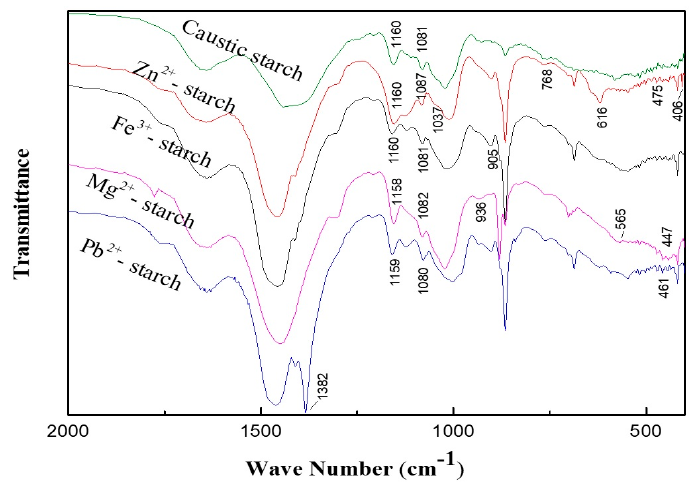
Figure 3. FTIR spectra of MSC.